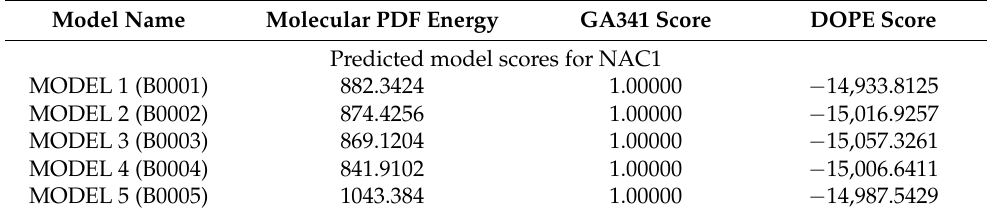
Figure 4. Homology modelling of ( I ) SlNAC1 and ( II ) DNA motif (5′-CATGTG-3’). Table 1. Molecular PDF energy, GA341 score and DOPE score for modelled SlNAC1.